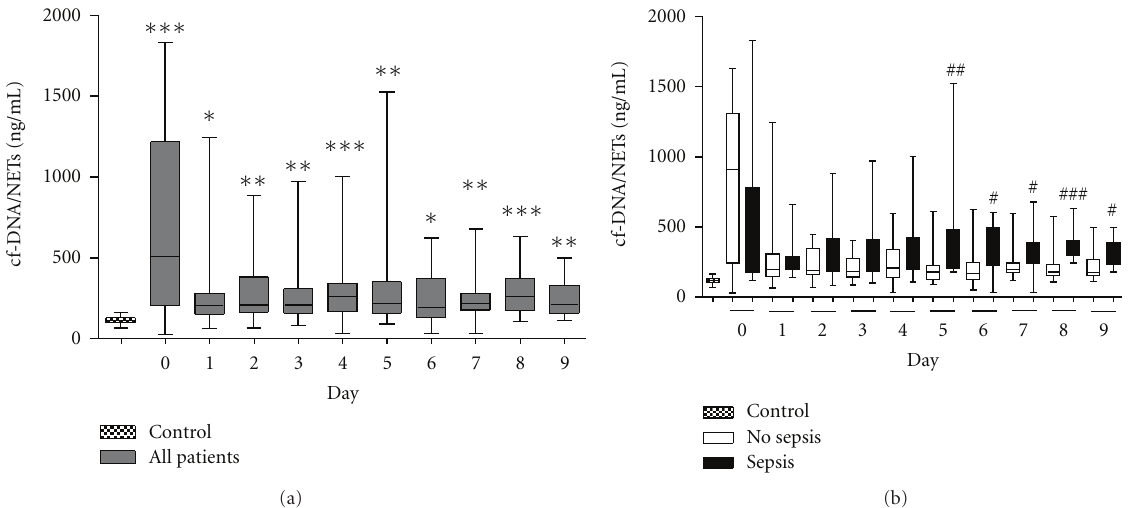
Figure 1: Kinetics of cfDNA/NETs after major trauma. (a) cf-DNA/NETs levels in patients ( n = 39) were significantly enhanced after trauma ( P < 0 . 01), versus control group (healthy volunteers). ∗ P < 0 . 05, ∗∗ P < 0 . 01, and ∗∗∗ P < 0 . 0001, (b) cfDNA/NETs levels in patients who developed sepsis during the first 10 days after trauma ( n = 14) were significantly elevated when compared to the values determined in patients with uneventful recovery ( n = 25). The horizontal line across the boxplots represents the median, and the lower and upper ends of the boxplots are the 25th and 75th percentiles, respectively. Whiskers indicate the minimum and maximum values, respectively versus no sepsis group at the same time. # P < 0 . 05, ## P < 0 . 01 and ### P < 0 . 0001.